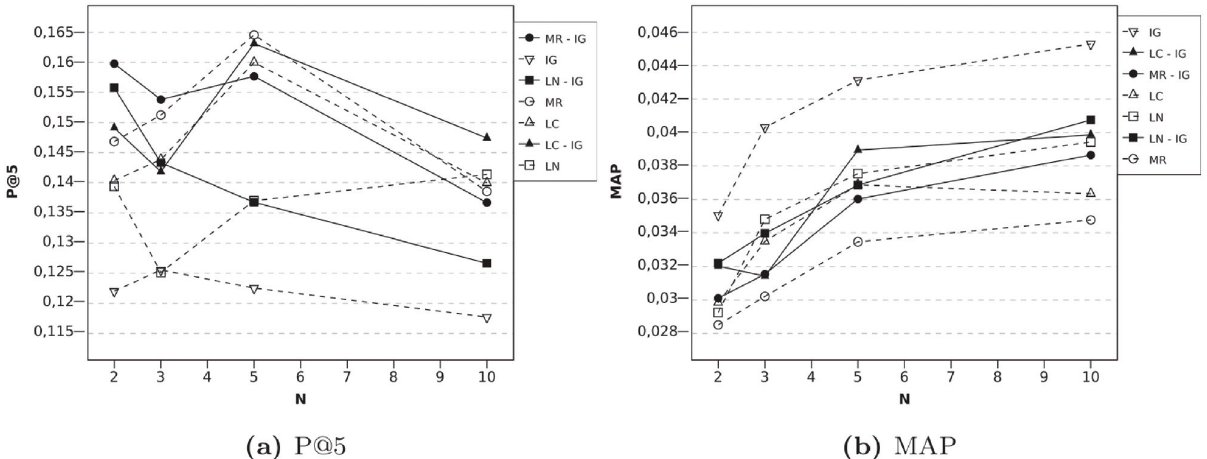
Fig 4. Evolution according to N, High Order Profile Expansion using serial combinations with IG technique and l = 2. Fig (a) reports P@5 results and (b) shows MAP.